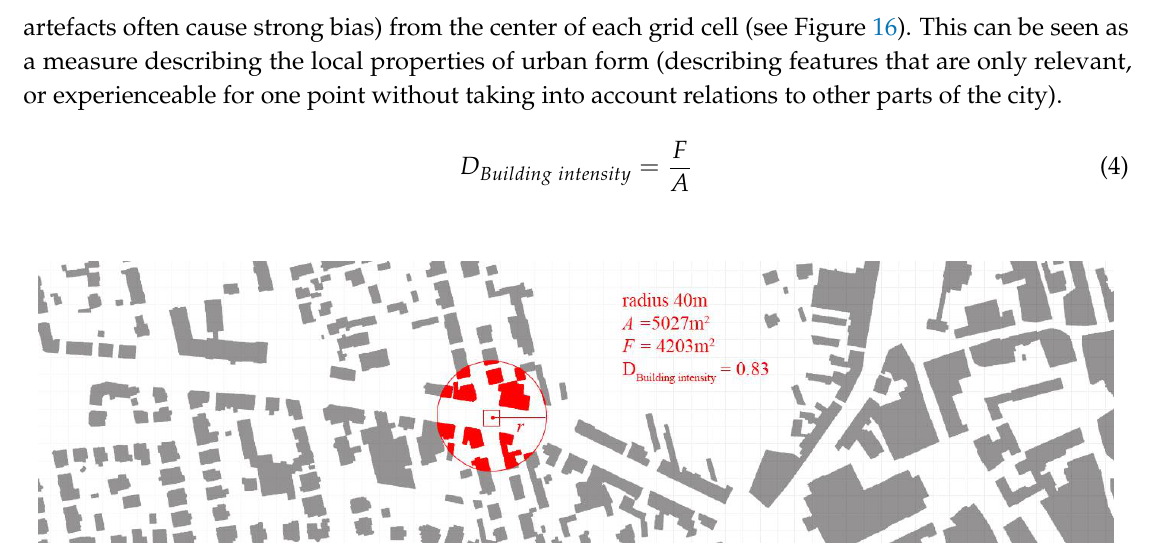
Figure 16. Radius-based building intensity calculation illustrated for one analysis grid cell.